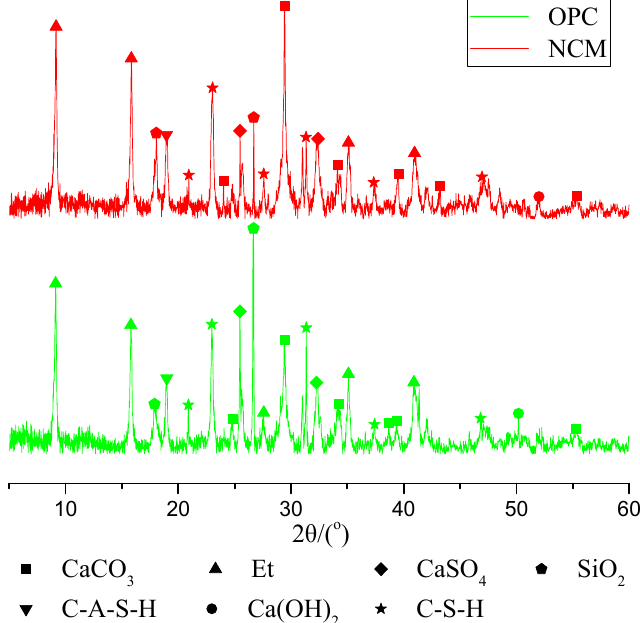
Figure 7. XRD images of NCM and OPC for 28 days of curing time. Processes 2018 , 6 , x FOR PEER REVIEW